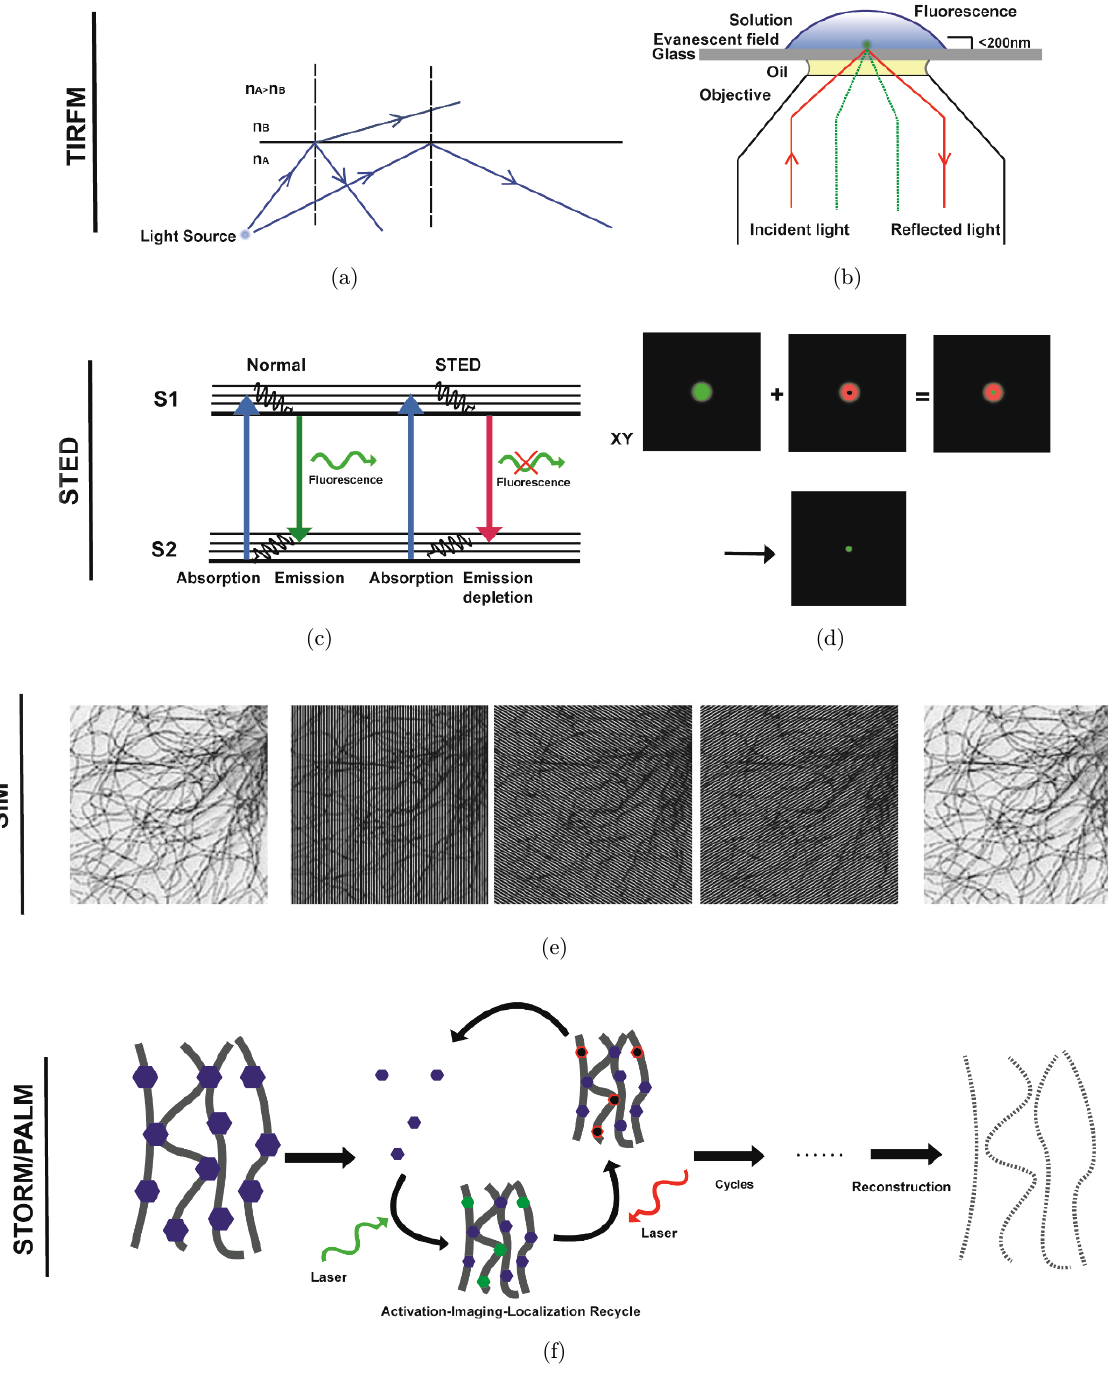
Fig. 1. Schematic diagram of principles of TIRFM, STED, SIM and (F)PALM/STORM. (a) As light spread from medium A to medium B ( n A > n B Þ , it re°ects and refracts at the same time. But it will totally re°ect when its incident angle is larger than the critical angle; (b) Under the case of total internal re°ection, °uorescence is emitted by evanescent ¯eld and collected by the objective lens; (c) Normally, °uorophores jump from the ground state (S2) to the excitation state (S1) after illumination, then return to the ground state and release °uorescence at the same time. However, the depletion beam interrupts this process and depletes the spontaneous °uorescence; (d) The doughnut-like depletion beam quench the spontaneous °uorescence around the central point, forming a smaller e®ective PSF;  Images are reconstructed by extracting the high frequency information, shifting it to low frequency, and then taking images at di®erent grating angles and phases; (f) Schematic diagram of (F)PALM/STORM. A small number of discrete °uorophores are detected stochastically at one moment. After a lot of cycles, the whole image is recovered with precise algorithms based on the location of each